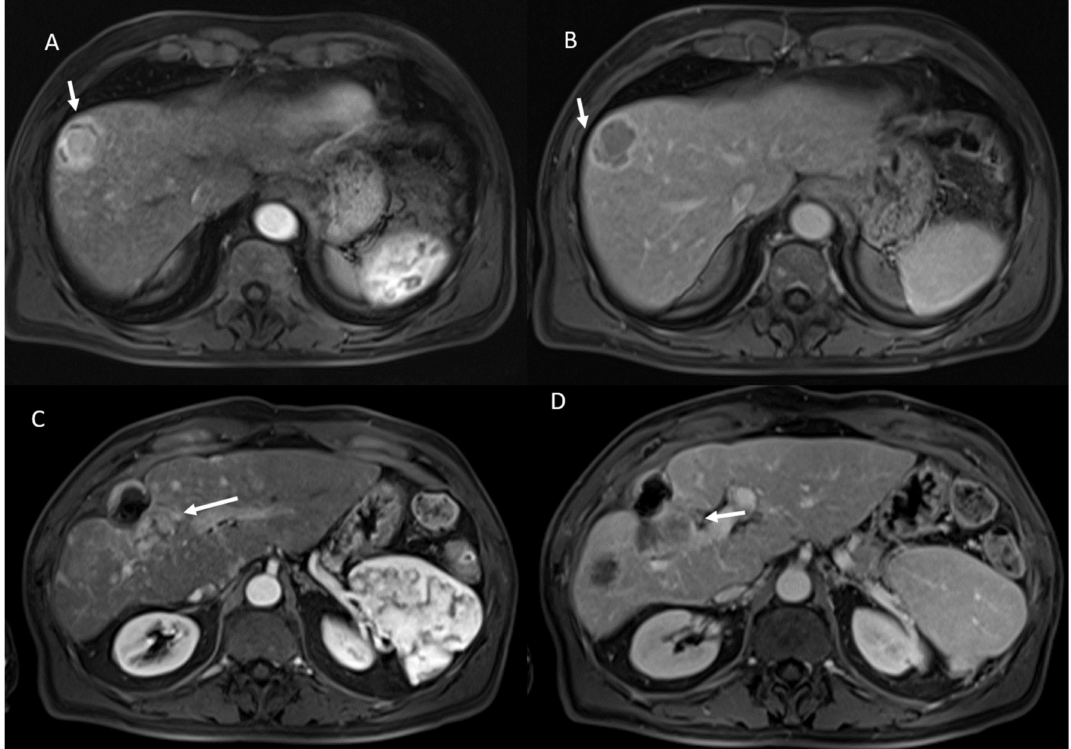
Figure 2. HCC on VIII hepatic segment: arrow shows APHE in arterial phase ( A ), with wash out and capsule appearance in portal phase ( B ). Post-treatment MRI: arrow shows APHE ( C ) and wash-out appearance in portal phase ( D ) in viable